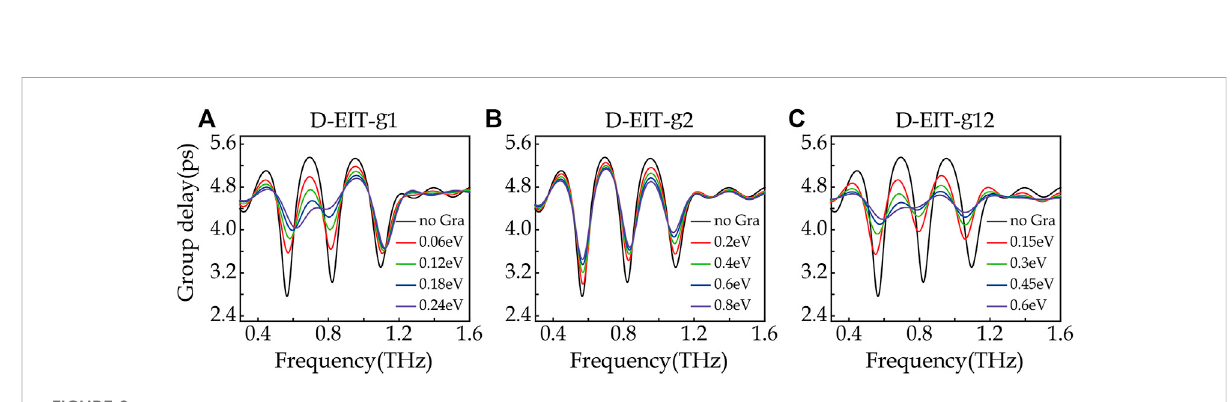
FIGURE 9 Group delay spectra as a function of E F for (A) D-EIT-g1, (B) D-EIT-g2, (C)